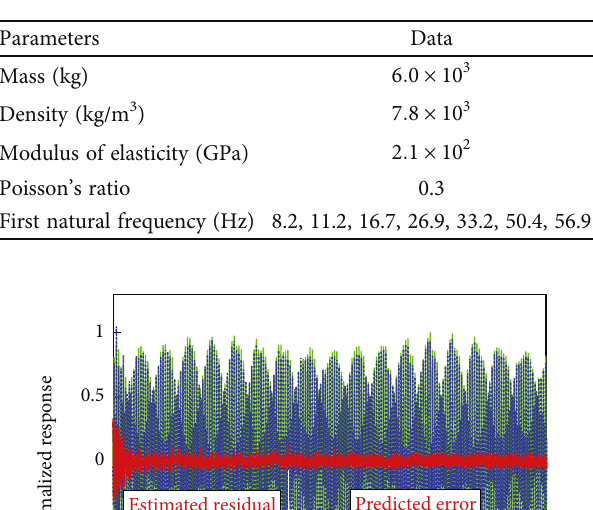
Figure 4: Simpli fi ed fi nite element model of the helicopter airframe. (a) The whole fuselage. (b) Enlargement of the front Table 1: Parameters of the beam structure.